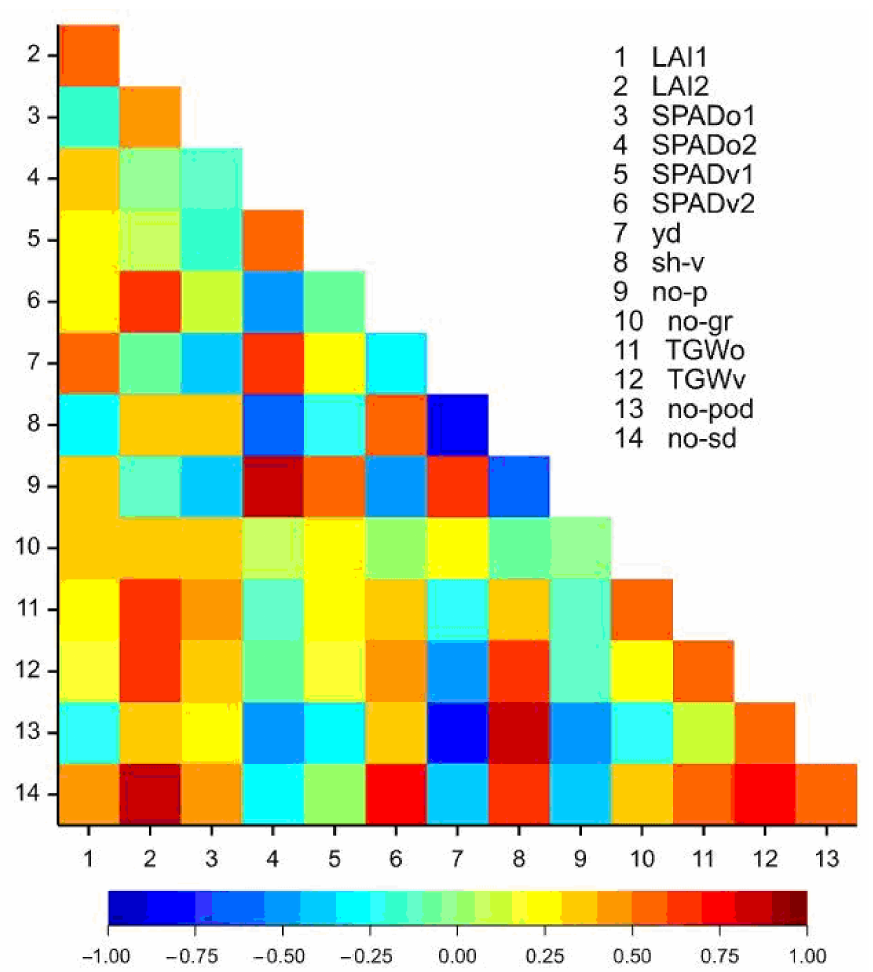
Figure 5. Heatmap for linear Pearson’s correlation coefficients between observed traits; r cr = 0.2875. The greatest diversity in all eleven traits, measured with Mahalanobis distances, was observed for the combination co-ce-12 (conventional variant-Celer-2012) and or-ce-13 (or- ganic variant-Celer-2013) (Table S3). The Mahalanobis distance between them amounted to 74.44. The greatest similarity (distance: 11.73) was observed between co-ce-14 (conventional variant-Celer-2014) and co-gr-14 (conventional variant-Grajcar-2014). The canonical analysis was performed to present the tested mixtures’ overall per- formances, based on all of the tested traits, for all of the three factors of this